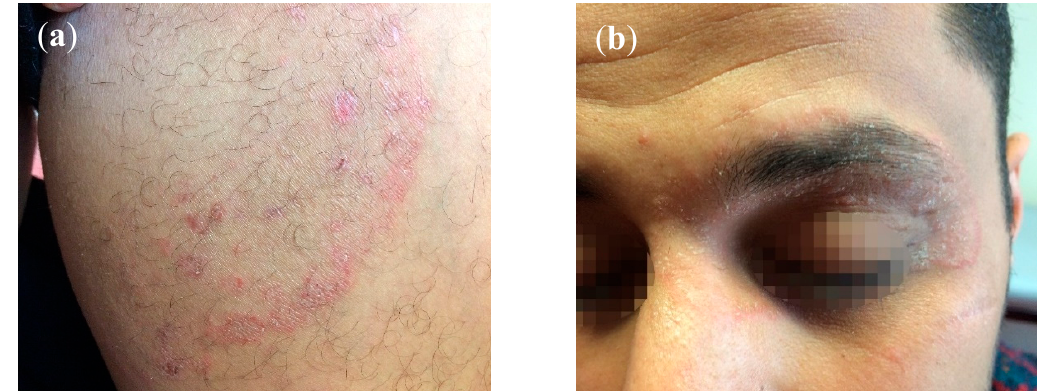
Figure 2. ( a ) Tinea cruris due to T . mentagrophytes VIII in a 28-year old male from Libya residing in Germany for about three years. Patient No. 10. Laboratory number of the fungal isolate: 202953/2019. ( b ) Accompanying tinea faciei of the same patient involving the left upper and lower eyelids.